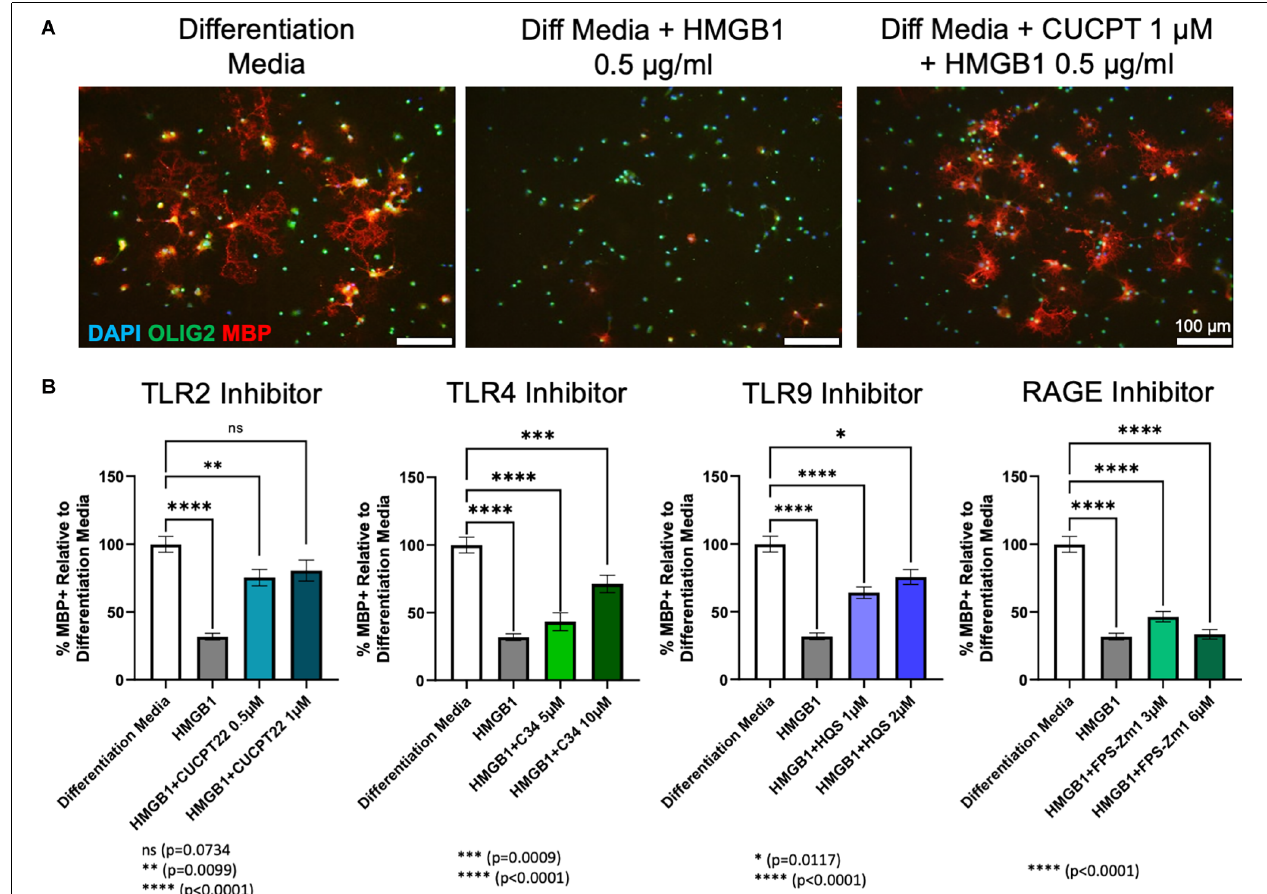
FIGURE 4 | HMGB1 inhibited OPC differentiation via TLR2/1 receptors. (A) Differentiation of rat OPC cultures after 72 h of treatment with differentation media, differentiation media plus HMGB1 or differentiation media plus HMGB1 and CU CPT22. (B) Quantification of the amount of differentiation, as measured by the percent of MBP+ cells, normalized to differentiation media using each receptor inhibitor [Not shown: all conditions are significantly different from HMGB1 ( p < 0.0001), except FPS-Zm1 3 µ M and 6 µ M (ns)]. Analyzed by one-way ANOVA, where ∗∗∗∗ P ≤ 0.0001; ∗∗∗ P ≤ 0.001; ∗∗ P ≤ 0.01; and ∗ P ≤ 0.05. ns when P > 0.05. Scale bar = 100 µ